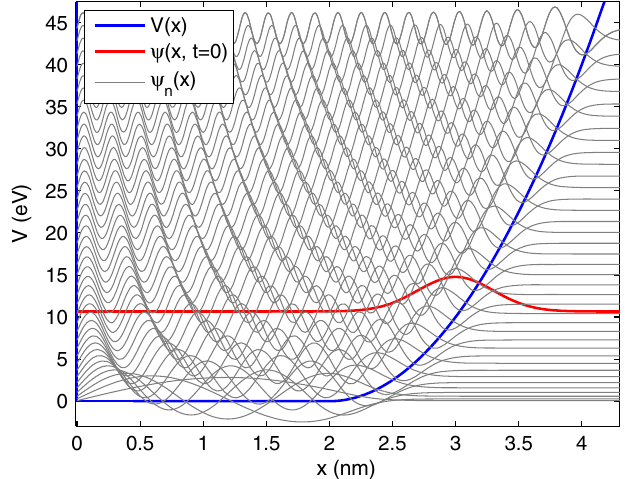
FIG. 1. Potential for an electron V ð x Þ . The initial state c ð x; t ¼ 0 Þ and the first 40 energy eigenstates c their eigenvalues are